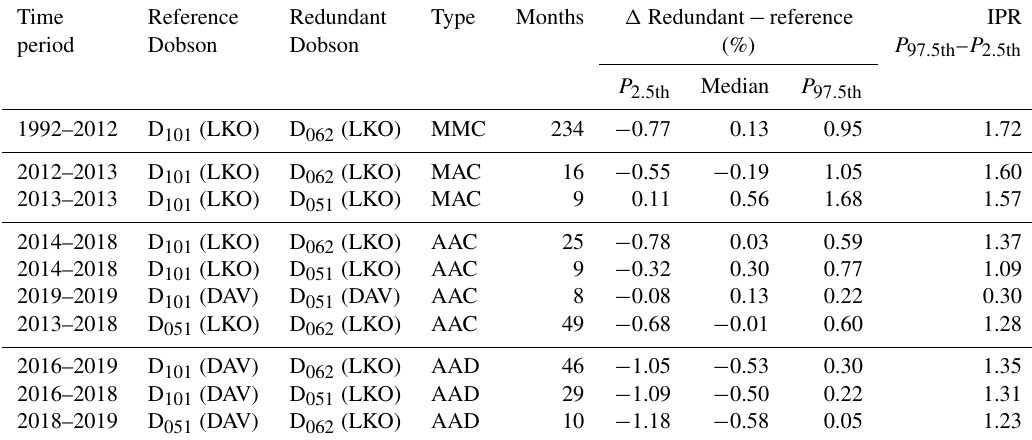
Figure 5. Daily analysis results: time series of the monthly median of the relative difference (cid:49) 062–101 = δ D σ (b) between coincident measurements of the Dobson instruments D 062 and D 101 over the period 1992–2012. Calibration campaigns are denoted by the black lines. The shading and the error bars are for the IPR 97 . 5th–2 . 5th interval. Table 3. Mean monthly medians of parameters (cid:49) for the four subperiods. Time Reference Redundant Type Months (cid:49) Redundant − reference IPR period Dobson Dobson